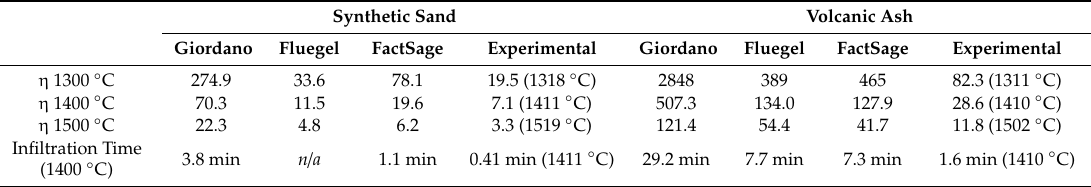
Table 7. Viscosity ( η ) values (in Pa · s) as a function of temperature, model, and glass composition. Thepredictedtimetocompletetheinfiltrationofa200 µ mthickthermalbarriercoating(TBC)(dependent on viscosity) at 1400 ◦ C is given for synthetic sand [35,36] and volcanic ash glasses. The expected